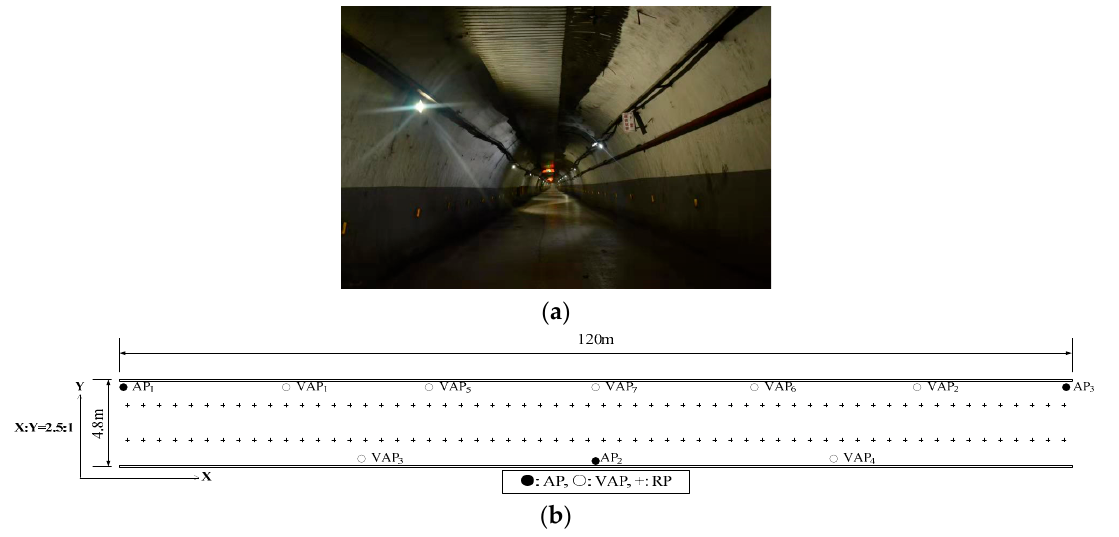
Figure 9. The experimental positioning scenario: ( a ) Picture of the underground tunnel; ( b ) Plan of the underground tunnel.